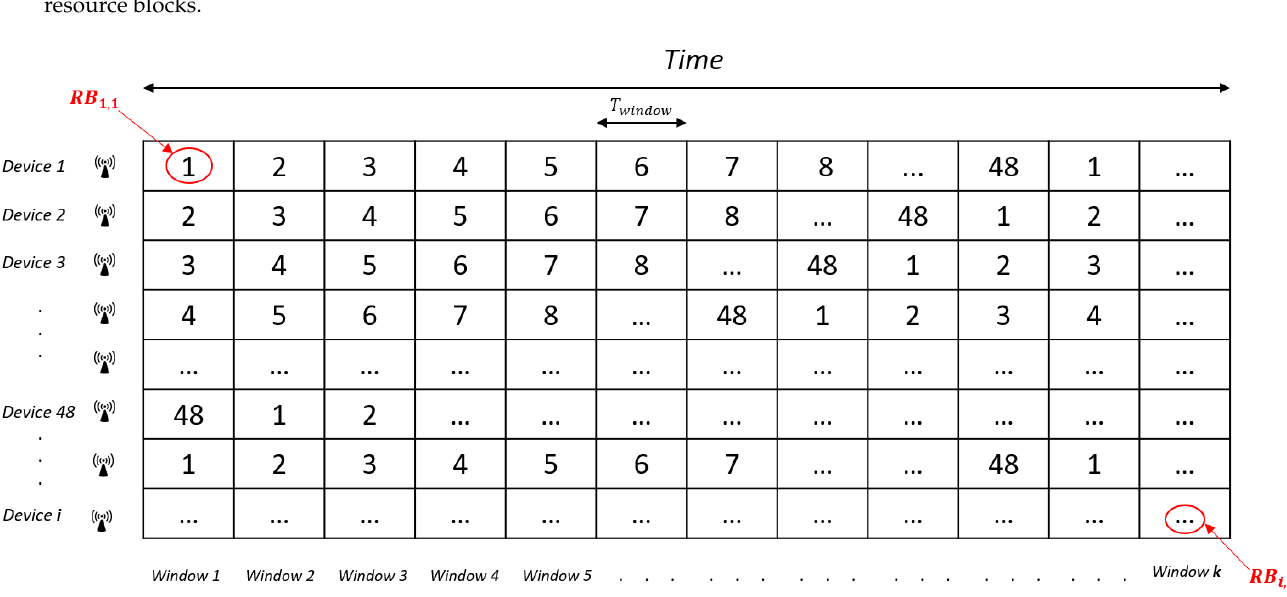
Figure 3. Join scheme in Collision Avoidance Resource Allocation (CARA) with the assignment for the assignment of resource blocks.